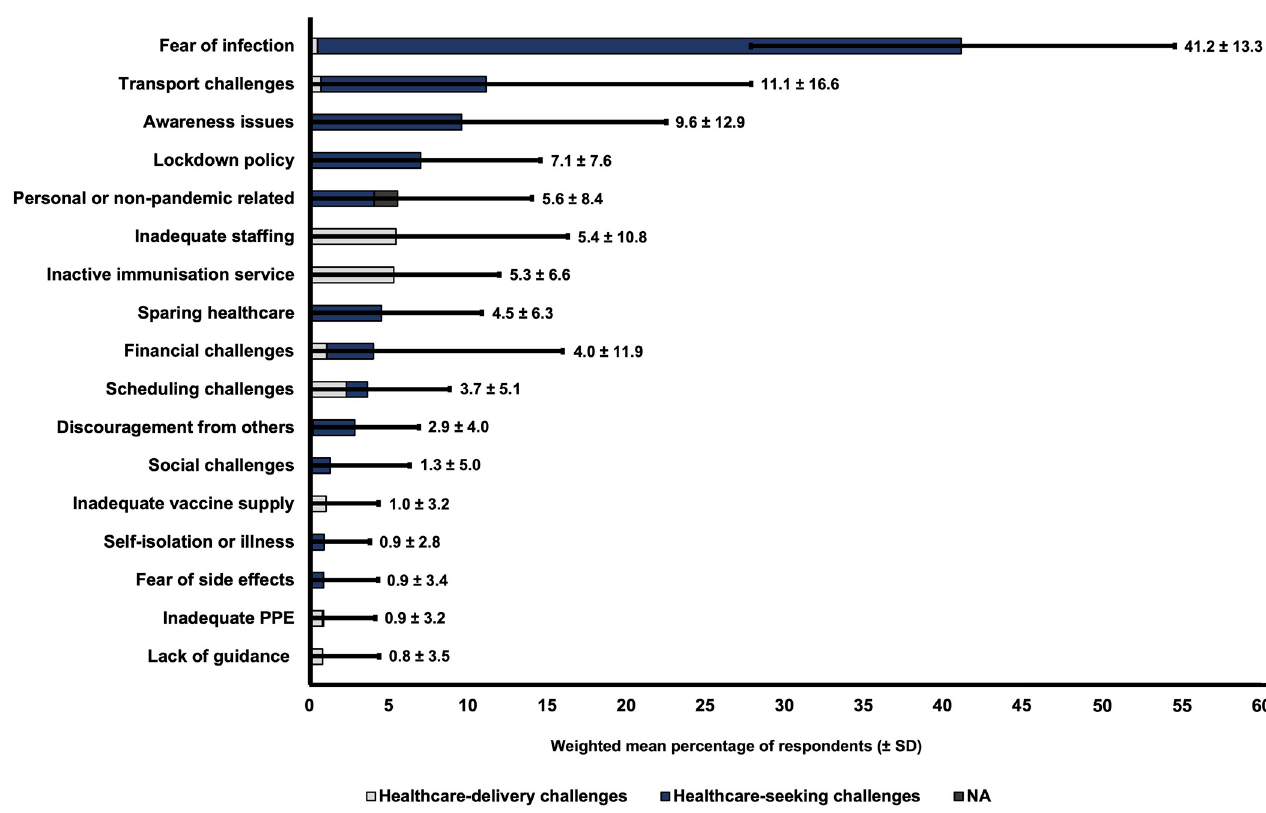
Fig 4. Weighted mean percentage of total responses ( ± standard deviation) for each coded reason for disruptions to routine child immunisations, sub- divided into healthcare-seeking and healthcare-delivery challenges (n =